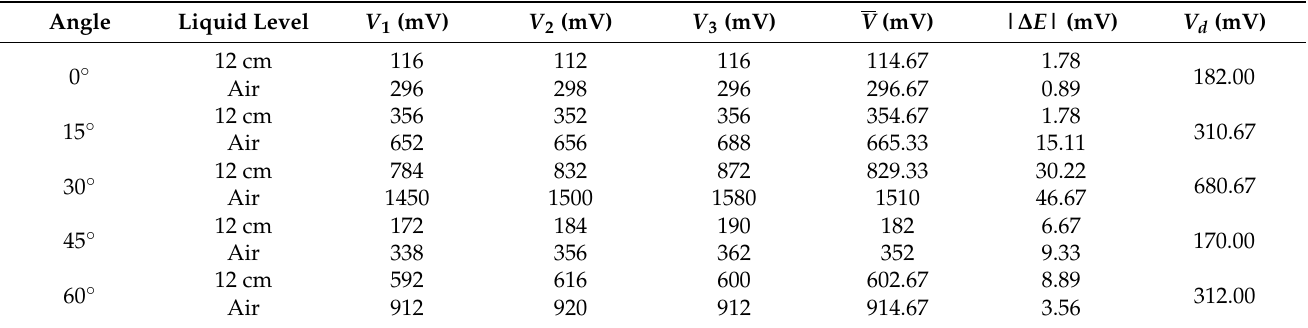
Table 2. Evaluations of different inclination angles.